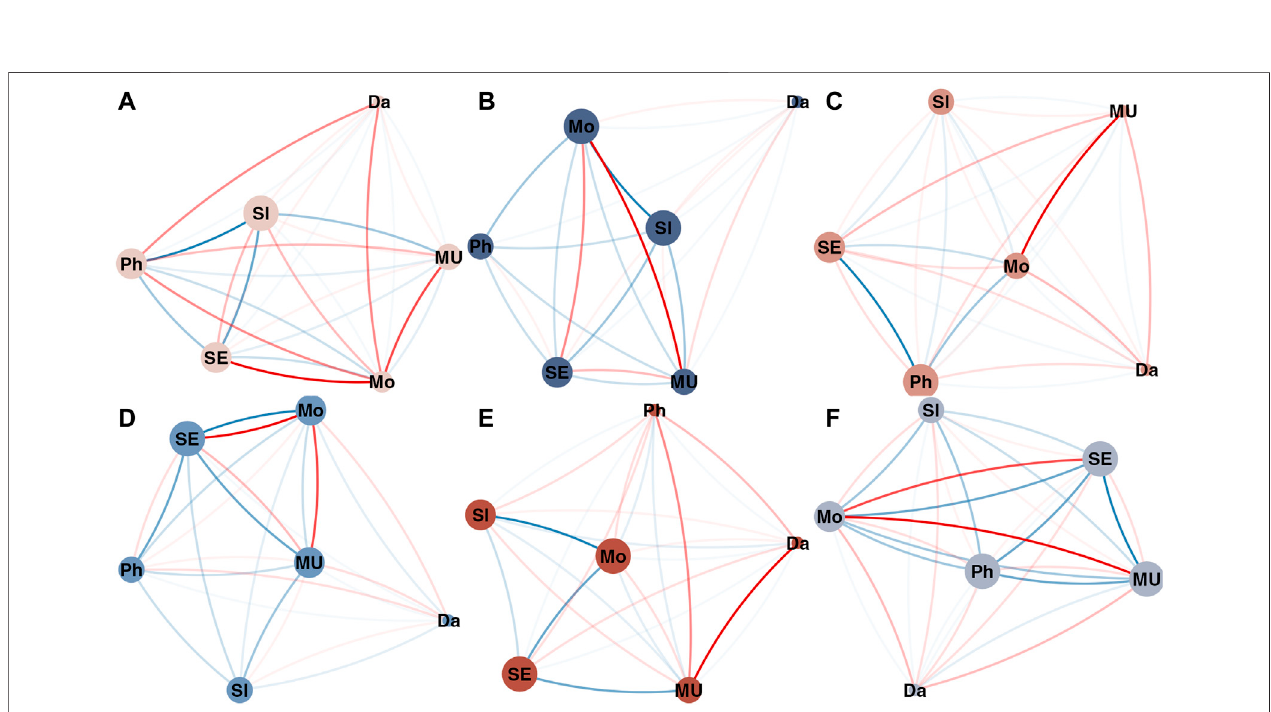
FIGURE 6 | Multiplex cumulative Recurrence Networks for different phases of the experiment: (A) Baseline; (B) Start double blind; (C) Start reduction; (D) Post reduction; (E) Criticaltransition; (F) Post reduction(additional).EachvertexrepresentsacumulativeRecurrenceNetwork(see Figure5 ).TheedgesrepresentInter-layer Mutual information (blue) and Edge Overlap (red). The second part of the post reduction phase after the critical transition is not shown here.